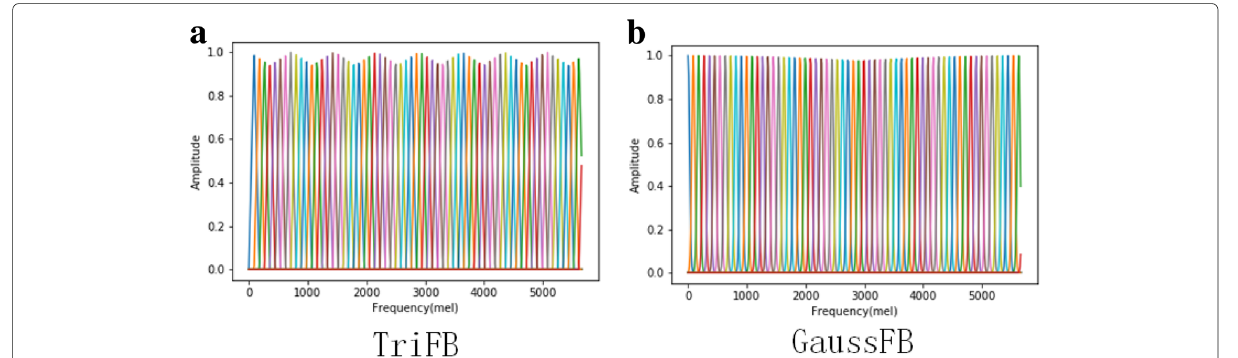
Fig. 3 Shape of frequency filter banks. a The triangular filter banks. b The gaussian filter banks